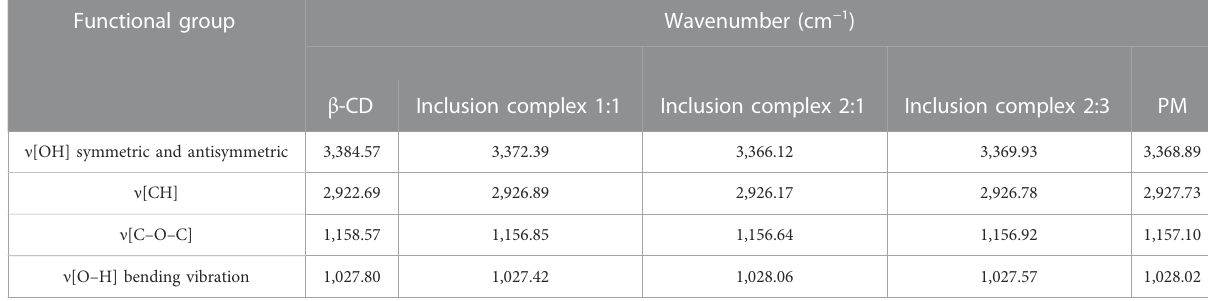
TABLE 1 Comparison between the intensity of free β -cyclodextrin, inclusion complexes, and physical mixture. Functional